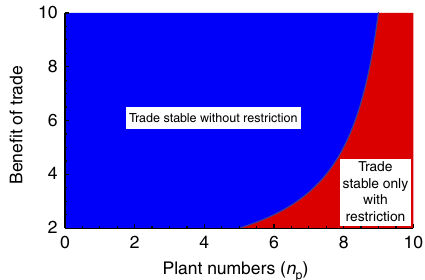
Figure 1 | The effect of phosphorus restriction on the stability of mutualistic trade. In the blue region, mutualistic trade is favoured with or without fungal phosphorus restriction. In the red region, mutualistic trade is only favoured when we allow fungal phosphorus restriction. Restriction favours trade when it would otherwise collapse because the benefit of trade (relative increase in mutualism efficiency if plants rely more on trade for phosphorus) is too